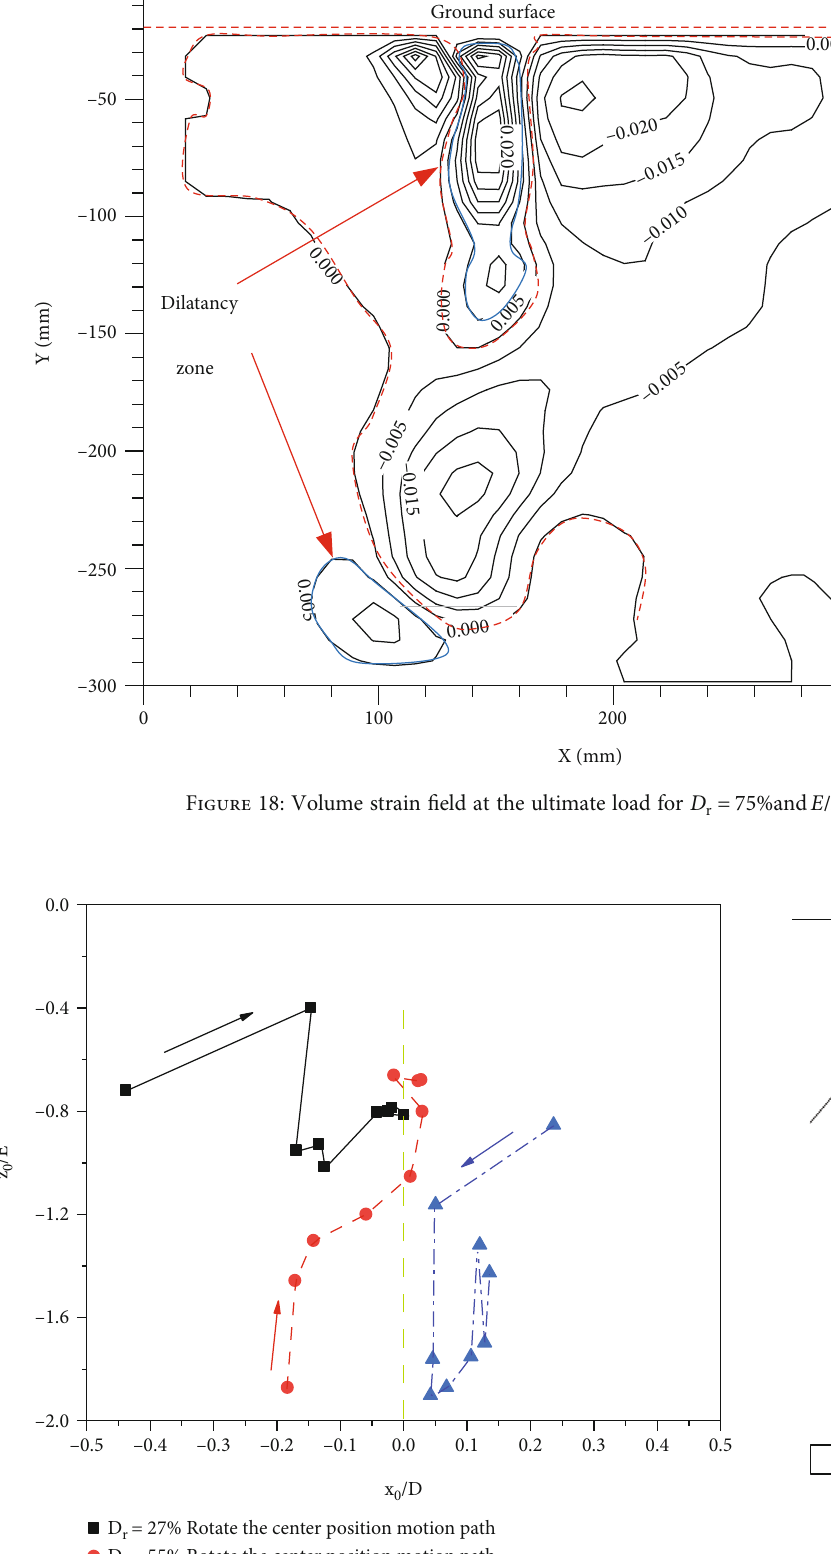
Figure 19: Rotation path of the center position ’ s motion.